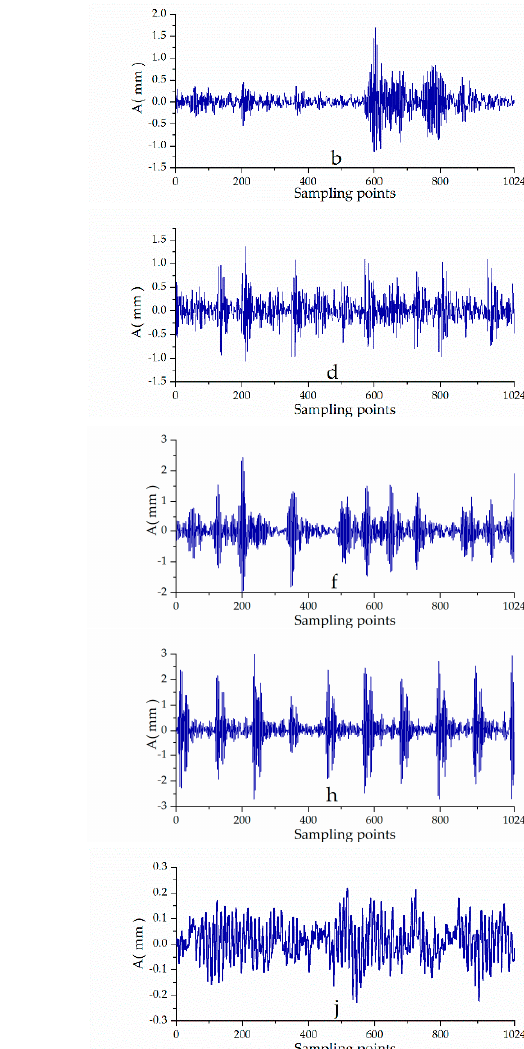
Figure 5. Rolling bearing test platform (Case Western Reserve University (CWRU)).